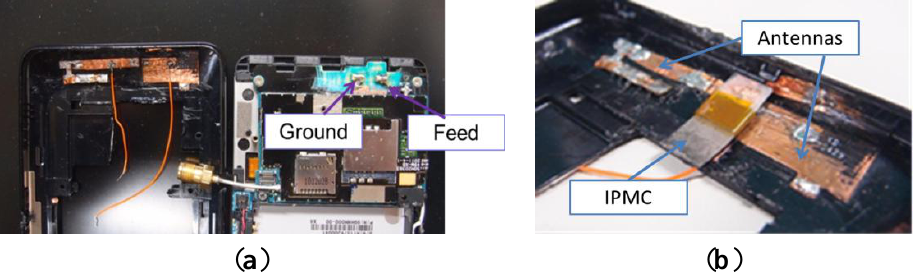
Figure 9. ( a ) Structure of antennas in mobile phone model; ( b ) IPMC switch connects two antenna strips.